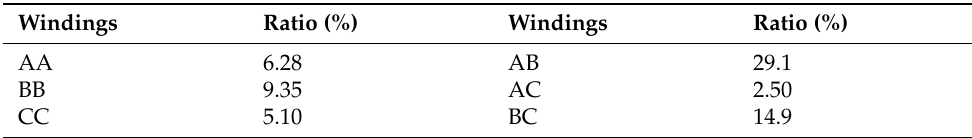
Table 3. Ratio of the inductance change of the windings.